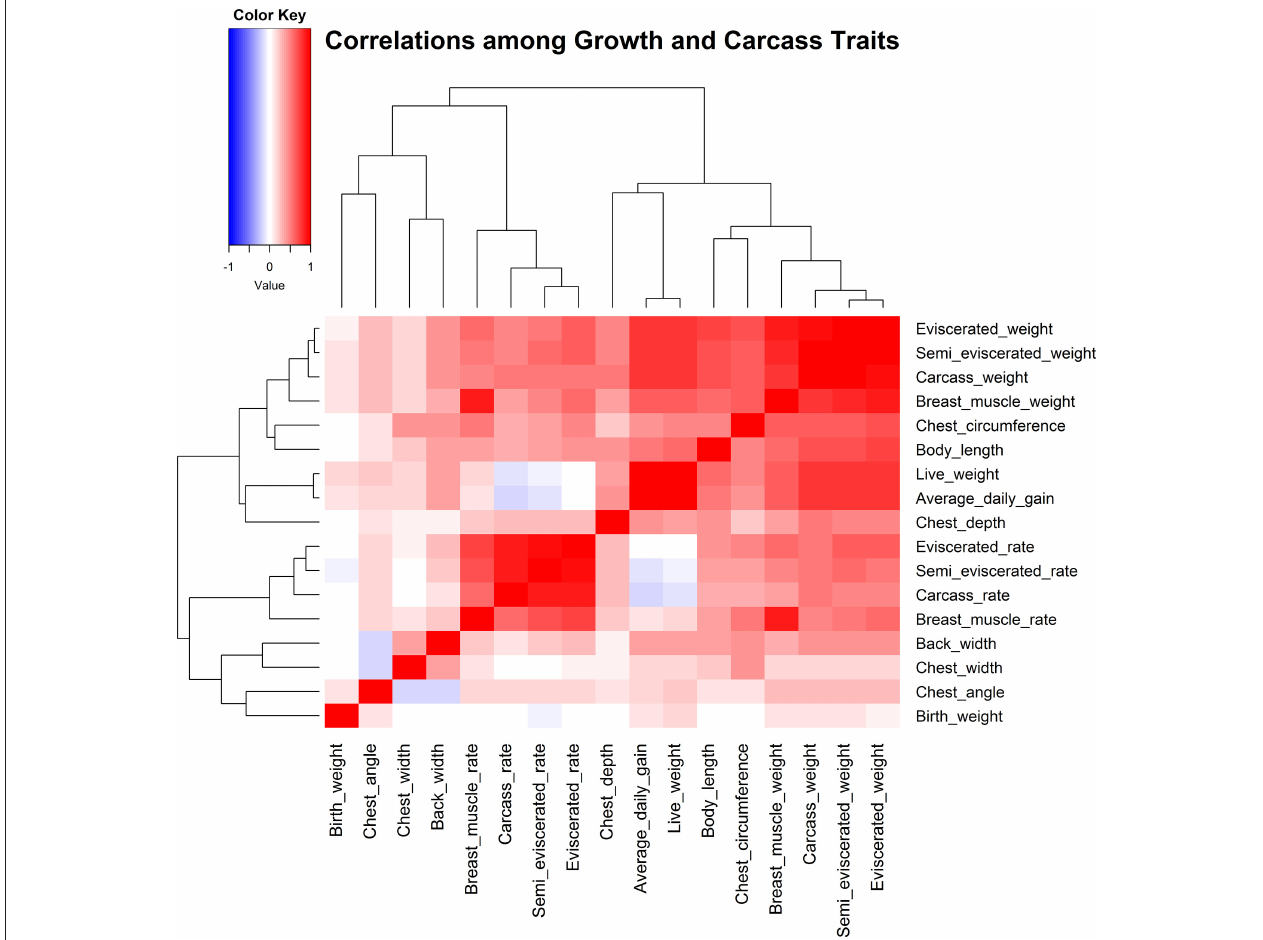
FIGURE 1 | Correlation analysis among 17 traits related to growth and carcass.